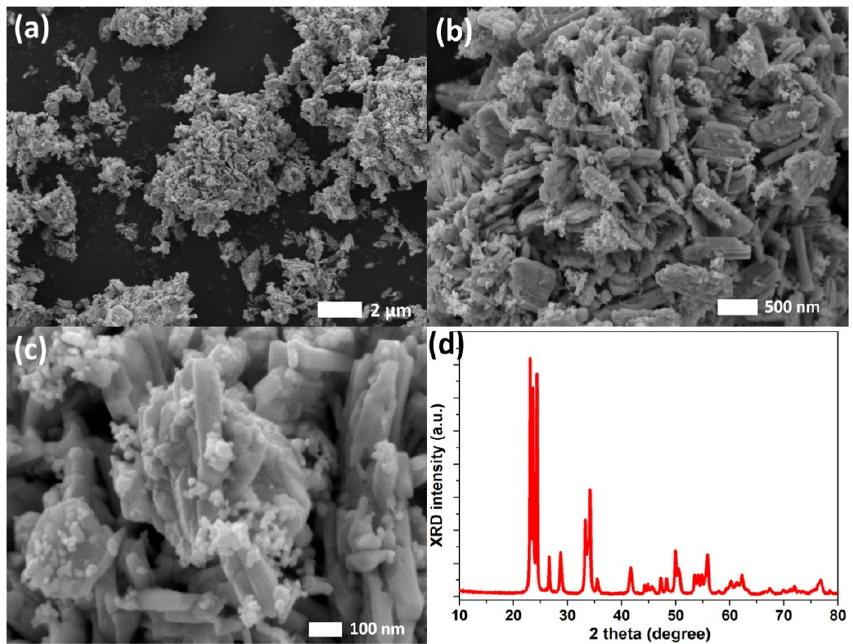
Figure 8. SEM images of WO 3 in low ( a ) and high ( b , c ) resolutions. ( d ) XRD pattern of 1-D WO 3 revealing monoclinic phase. Reproduced from reference [154] with permission from Elsevier, copyright 2022.